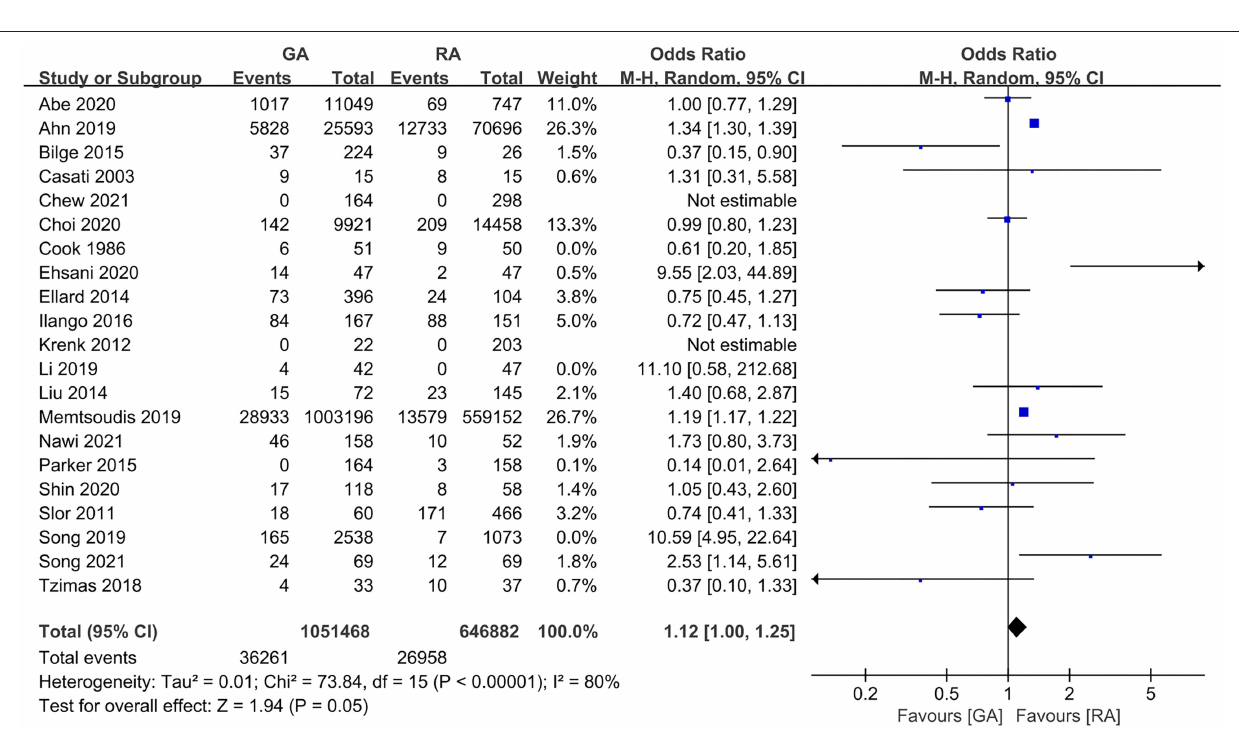
FIGURE 5 | The pooled result of POD incidence in surgical patients with GA and RA after excluding the studies without the information on preoperative cognitive or neuropsychological assessment.